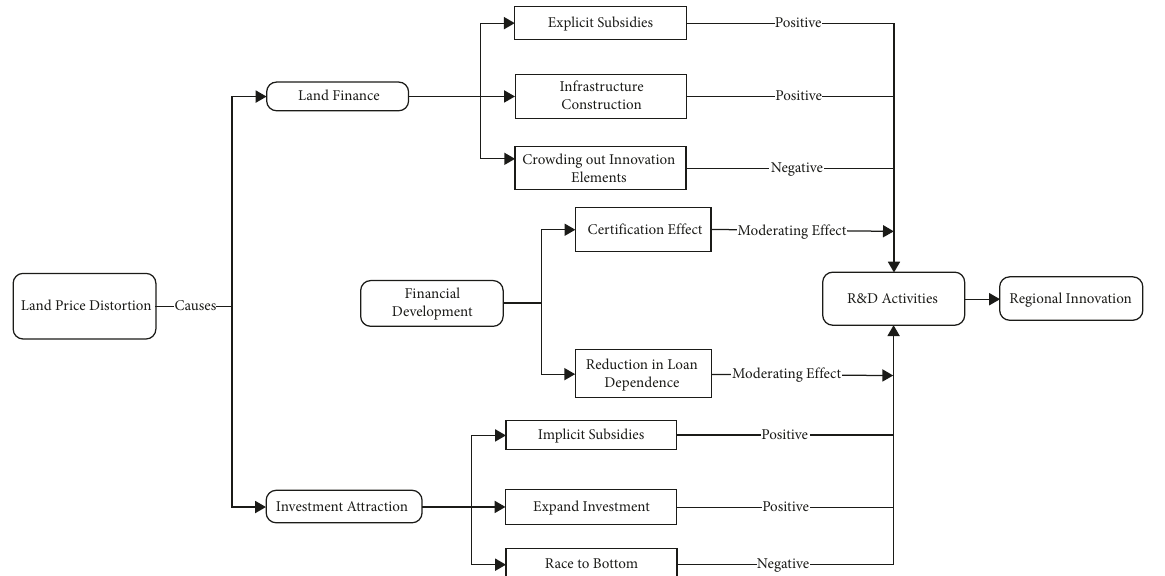
Figure 1: The relationship between land price distortion, local financial development level, and regional innovation